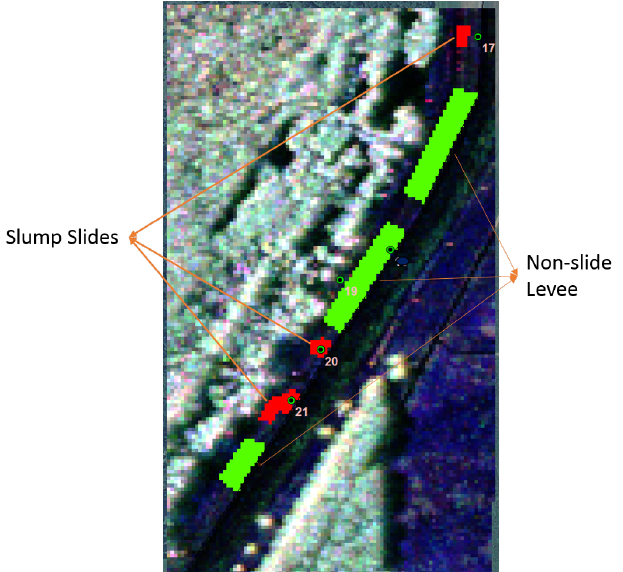
Figure 5. Training mask for UAVSAR subset with two ground truth classes: slump slide and non-slide/healthy Levee with three-band UAVSAR (HH, HV, and VV) image at the